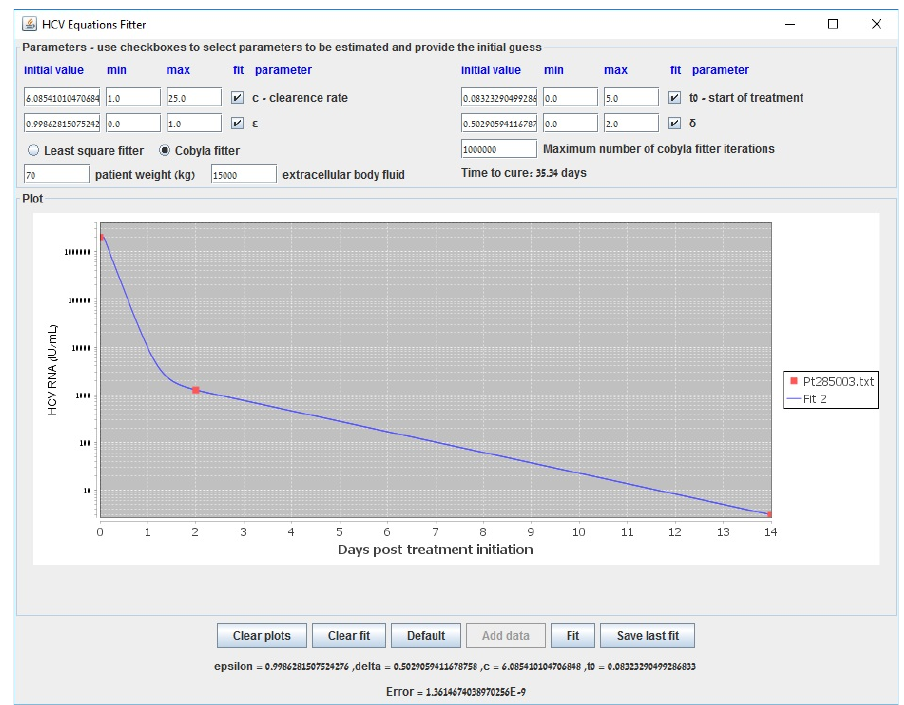
Figure A7. Biphasic model fitting example with data taken from [36] of a patient who was treated with epclusa. In this particular case, COBYLA was selected instead of LSF and succeeded to yield a